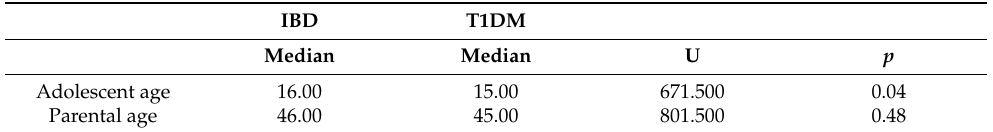
Table A2. The results of Mann-Whitney U tests comparing the adolescent and parental age between the IBD and T1DM groups. IBD